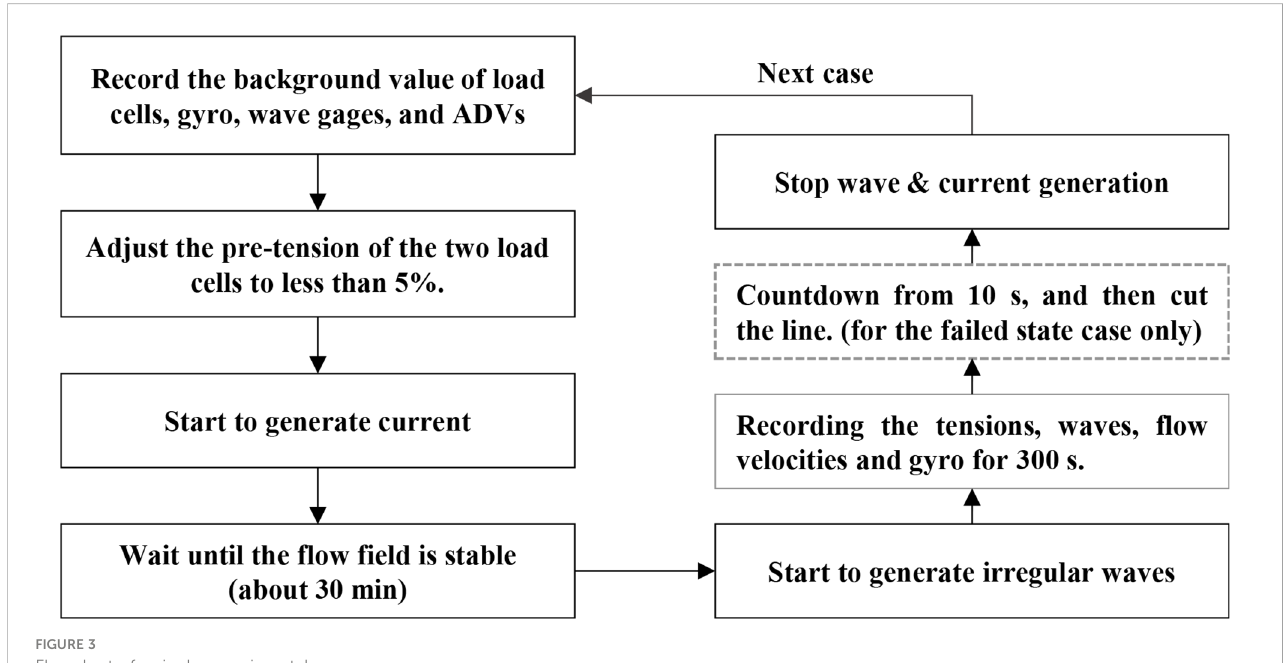
FIGURE 3 Flowchart of a single experimental